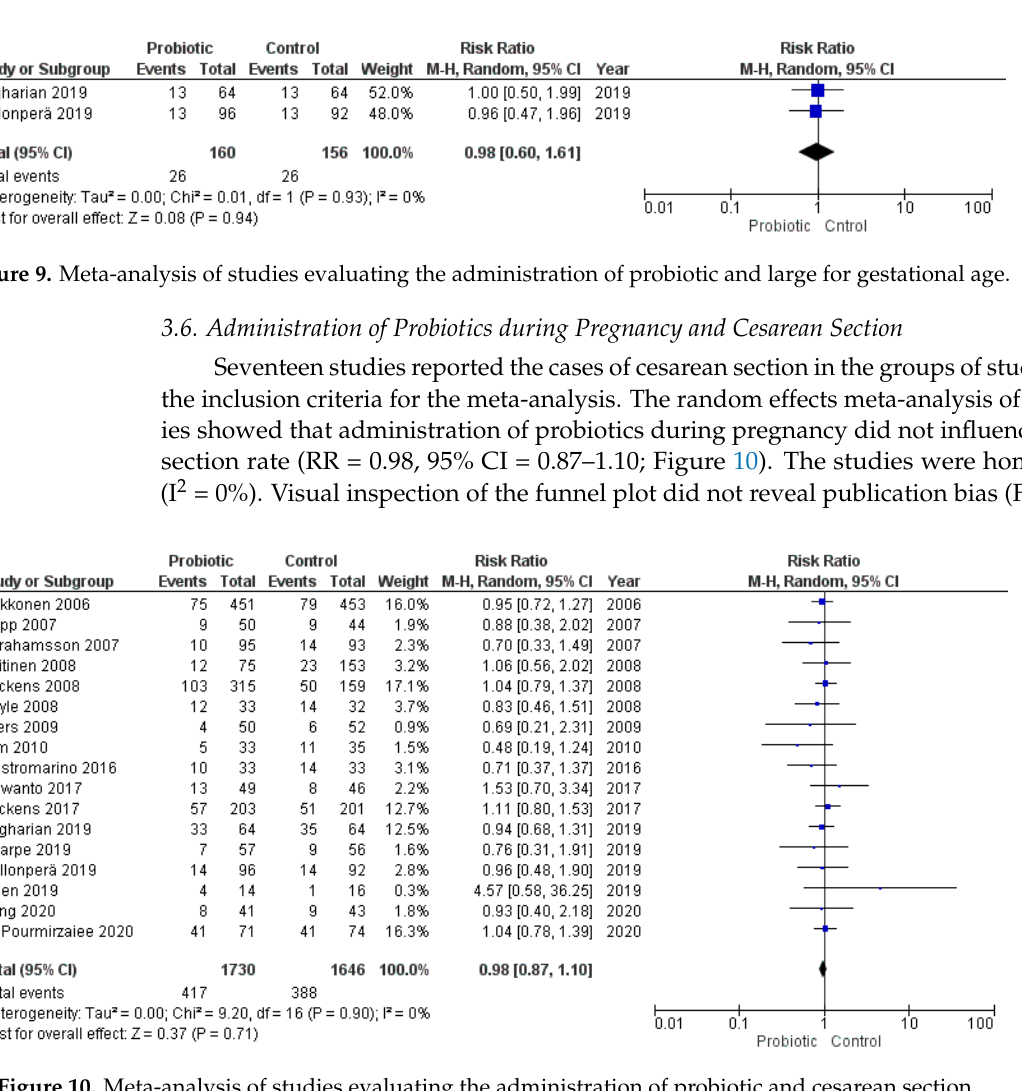
18 of 25 Figure 7. Funnel plot of studies evaluating the administration of probiotic and birth weight. Subgroup analysis of only the eight studies that provided birth weight as mean ± standard deviation did not significantly modify the meta-analysis results (MD = 10.80, 95% CI = − 28.03–49.62, I 2 = 0%; Supplementary 4: Figure S6). In the same fashion, subgroup analysis excluding studies conducted during the last 4-6 weeks of gestation did not mod- ified the meta-analysis results (MD = − 7.43, 95% CI = − 80.27–65.41.01, I 2 = 18%; Supple- mentary 4: Figure S7). We also separately analyzed two studies that used Lactobacillus rhamnosus GG providing data on birth weight yielding similar results (MD = 16.80, 95% CI = − 82.40– 116.01, I 2 = 0%; Supplementary 4: Figure S8). None of the studies that provided the cases of low birth weight (<2500 g at birth) or SGA (birth weight <10 th percentile for the gestational age) met the inclusion criteria for the meta-analysis. On the other hand, three studies reported the cases of macrosomia (>4000 g at birth) in the cohort of study and two other trials reported the cases of LGA (birth weight >90 th percentile for the gestational age). However, Sahhaf et al. [70] did not specify the definition of macrosomia used. The meta-analysis of these studies showed that probi- otic consumption during pregnancy was not associated with an increased risk of macro- somia or LGA (macrosomia: RR = 0.84, 95% CI = 0.30–2.34, I 2 = 60%; LGA: RR = 0.98, 95% CI = 0.60–1.61, I 2 = 0%; Figures 8 and 9). Exclusion of the study conducted by Sahhaf et al. [70] (which was the main cause of heterogeneity) did not significantly modify this corre- lation (data not shown).